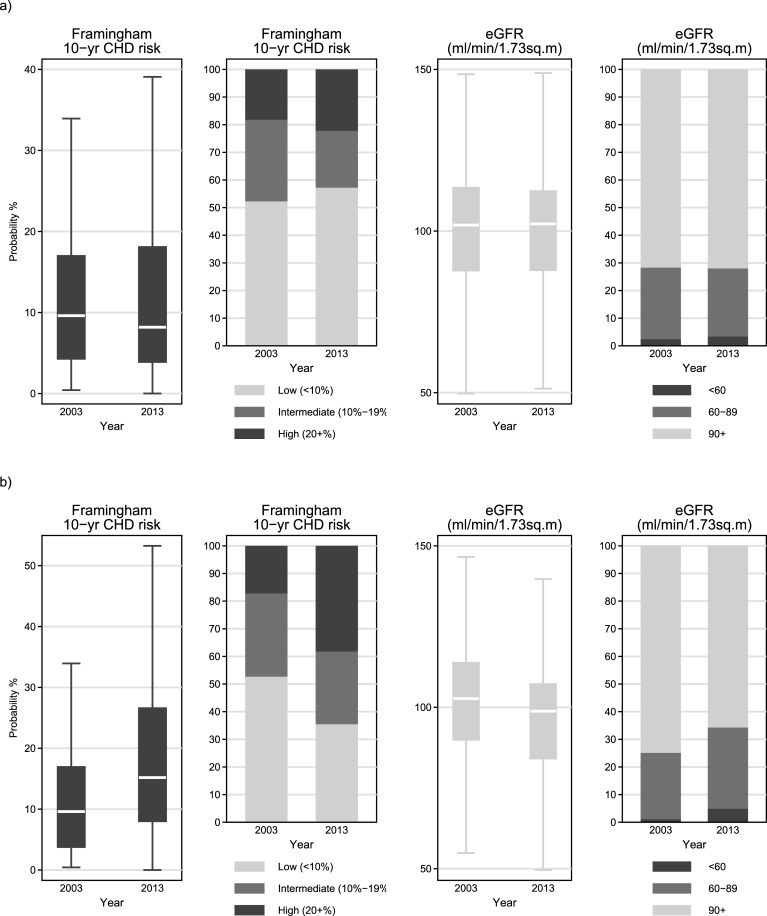
Framingham risk score and estimated glomerular filtration rate (eGFR) quantitatively in categories in a) open cohort (all eligible patients) and b) closed cohort (subgroup of common patients in 2003 and 2013).